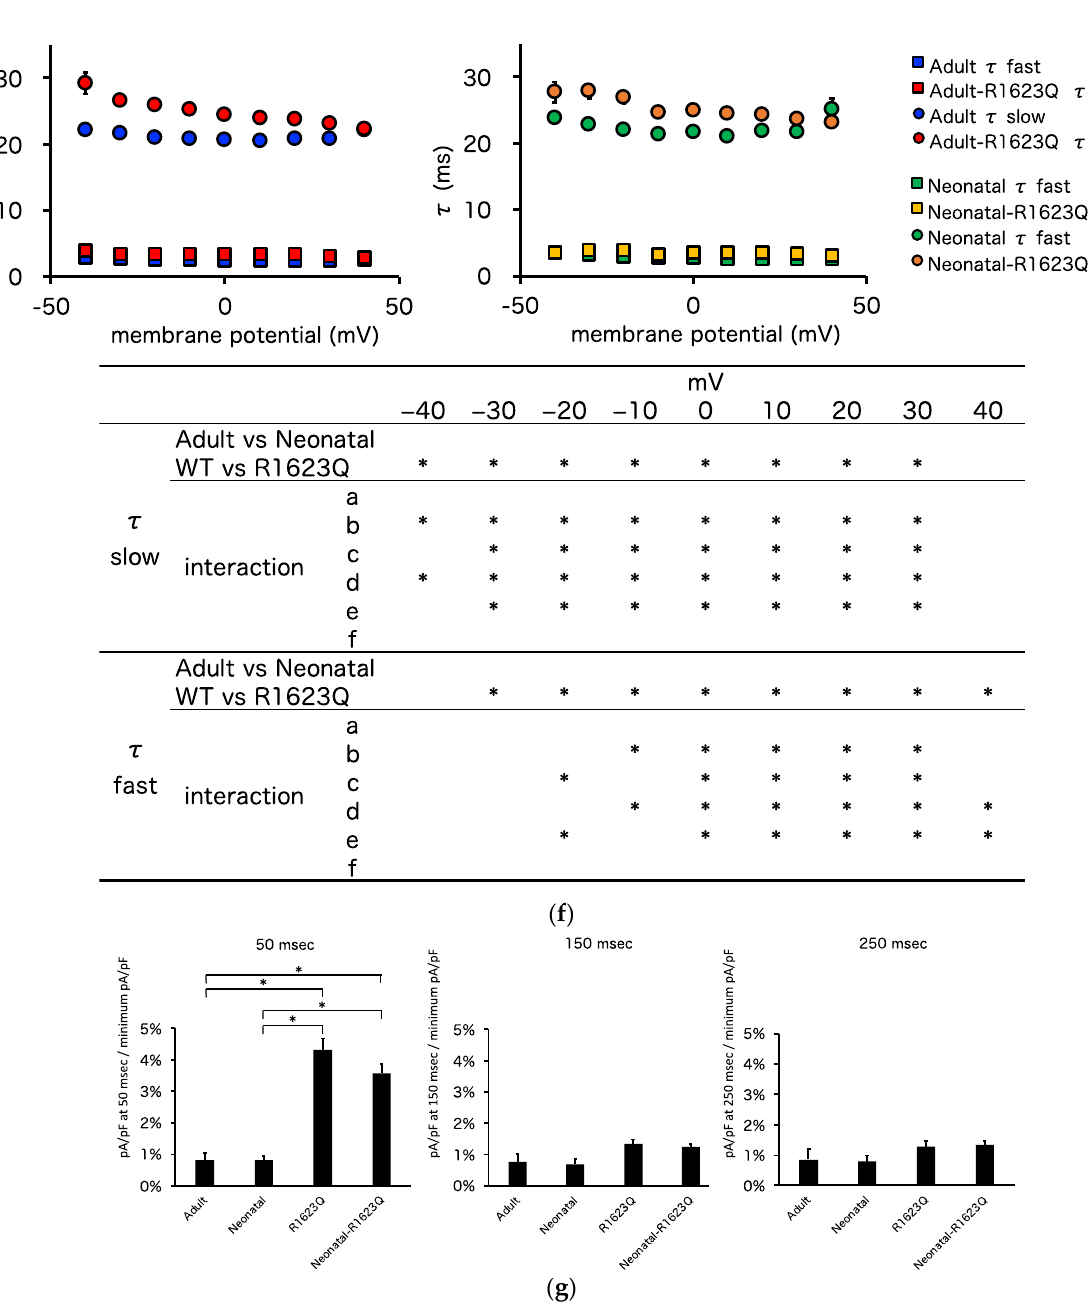
Figure 5. Whole-cell current recordings of ‘adult,’ ‘neonatal,’ ‘R1623Q,’ and ‘neonatal-R1623Q’ mutant Nav1.5 channels using automated patch-clamp. ( a ) Whole-cell I Na was elicited with the pulse protocol shown in the inset. ( b ) Normalized I Na for ‘adult’ (blue), ‘neonatal’ (green), ‘R1623Q’ (red), and ‘neonatal-R1623Q’ (orange). ( c ) Current–voltage relationship of peak I Na for ‘adult’ (blue), ‘neonatal’ (green), ‘R1623Q’ (red), and ‘neonatal-R1623Q’ (orange) variants was obtained by normalizing the peak current amplitude from pulse protocols shown in ( a ) to the cell capacitance. ( d ) The voltage dependence of channel activation (G-V) curves was represented for ‘adult’ (blue), ‘neonatal’ (green), ‘R1623Q’ (red), and ‘neonatal-R1623Q’ (orange) Nav1.5. ( e ) The voltage dependence of channel inactivation of ‘adult’ (blue), ‘neonatal’ (green), ‘R1623Q’ (red), and ‘neonatal-R1623Q’ (orange) Nav1.5. ( f ) Experimental data obtained for the current–voltage relationship were used to determine the inactivation time constant in the range of potential from − 40 to 40 mV. Current decay after the peak I Na was fitted to a bi-exponential function. The resulting time constant ( τ ) values were plotted against the applied voltage for ‘adult’ (blue) and ‘R1623Q’ (red) Nav1.5 ( left graph), and for ‘neonatal’ (green) and ‘neonatal-R1623Q’ (orange) Nav1.5 ( right graph). Two-way ANOVA test detected the significant difference (* p < 0.05) in the variables (WT vs. R1623Q mutation); further, the Sheff é test was performed. The statistical analysis results are summarized in the table below the